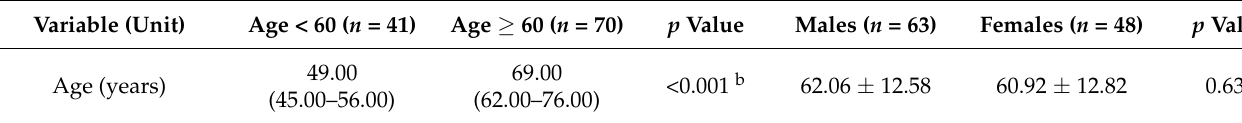
Table 2. Descriptive statistics and comparison results by age and sex in ischemic stroke